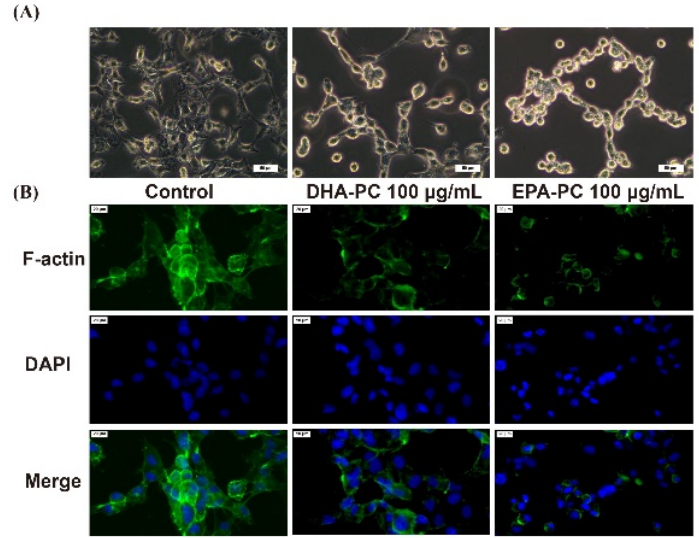
Figure 4. DHA-PC and EPA-PC destroyed the F-actin organization of 95D cells. ( A ) The morpho- logical change of 95D cells was taken under the optical microscope (Scale bar: 50 μ m). ( B ) Immuno- fluorescence analysis was presented using the fluorescence microscope (Scale bar: 20 μ m).